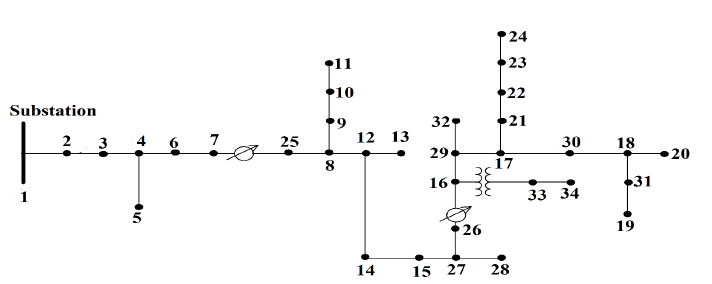
Figure 3. IEEE 34-node distribution test feeder [37]. Table 1. Line resistance and reactance